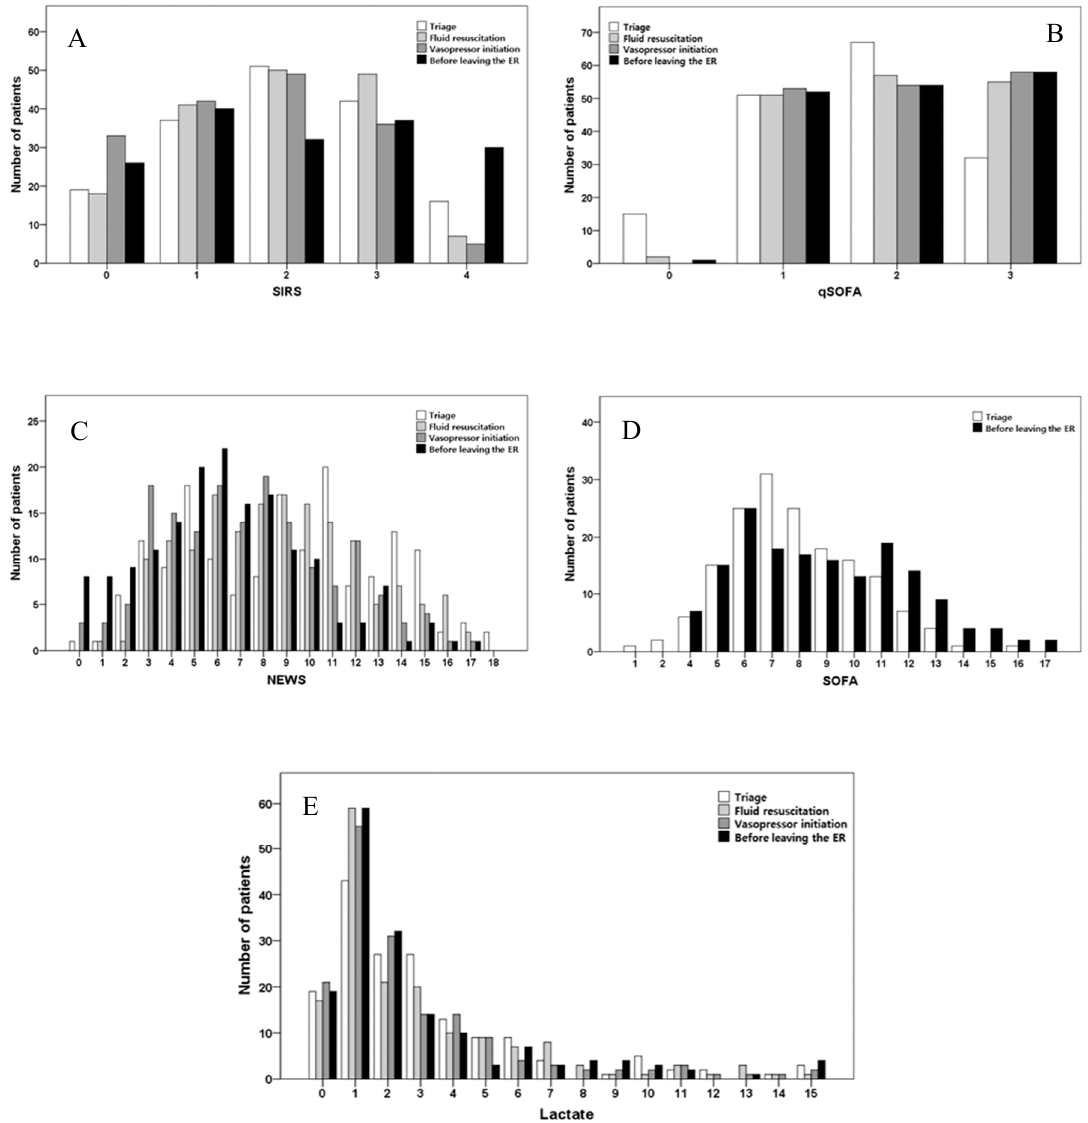
Figure 2. Distribution of patients according to severity score and lactate level. ( A ) Systemic inflammatory response syndrome (SIRS). ( B ) Quick Sequential Organ Failure Assessment (qSOFA). ( C ) National Early Warning Score (NEWS). ( D ) Sequential Organ Failure Assessment (SOFA). ( E ) Lactate.